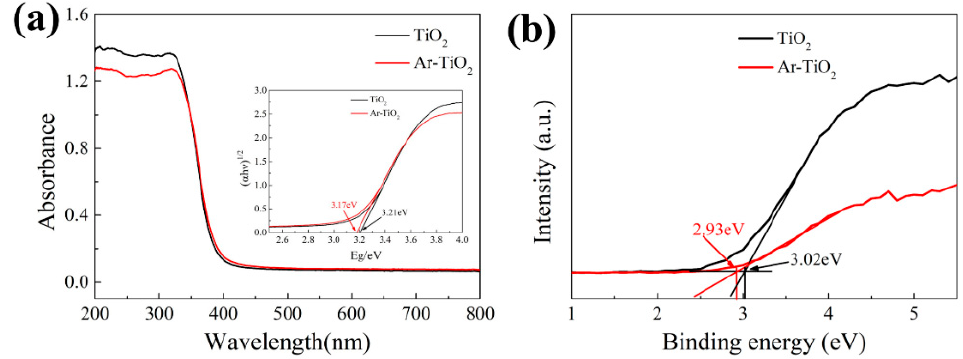
Figure 3. ( a ) Ultraviolet (UV)-visible absorption spectra DRS, the insets in Figure 3 ( a ) is the corresponding plots of transformed Kubelka-Munk function versus the energy of photon, ( b ) XPS valence band spectra.